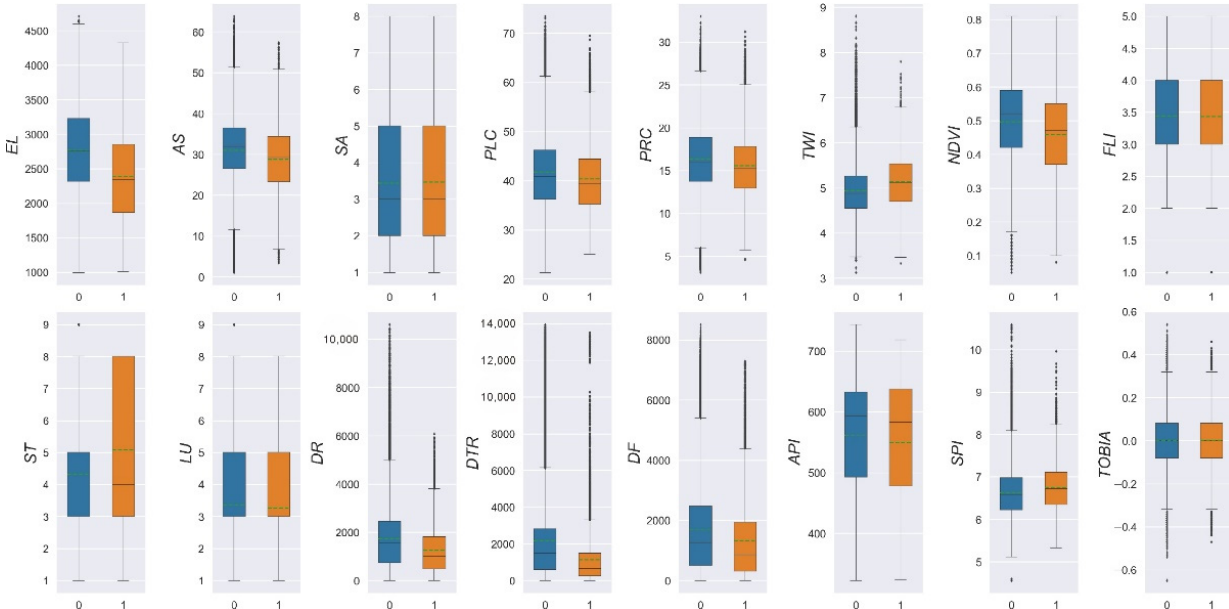
Figure 9. Box plots of the correlation factors for the unclassified landslide database. NLS non-landslides, LS landslide.